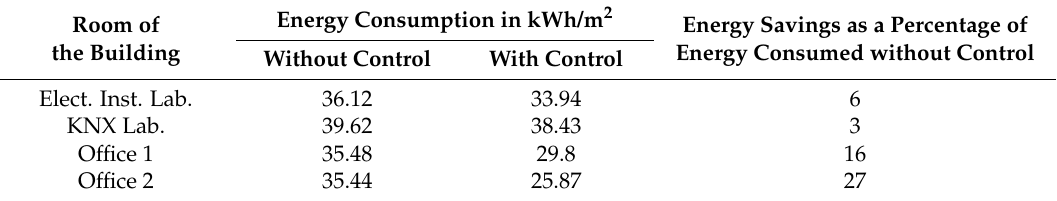
Table 5. Energy consumptions and energy savings in several rooms of